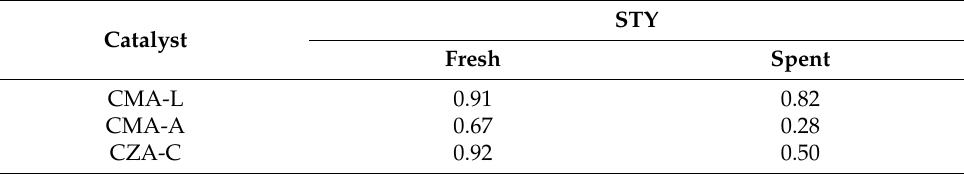
Table 2. STY of fresh and spent catalysts (reaction condition: 473 K, H 2 pressure: 2.5 MPa, H 2 /CHA molar ratio = 20:1, WHSV = 1.0 h − 1 ).